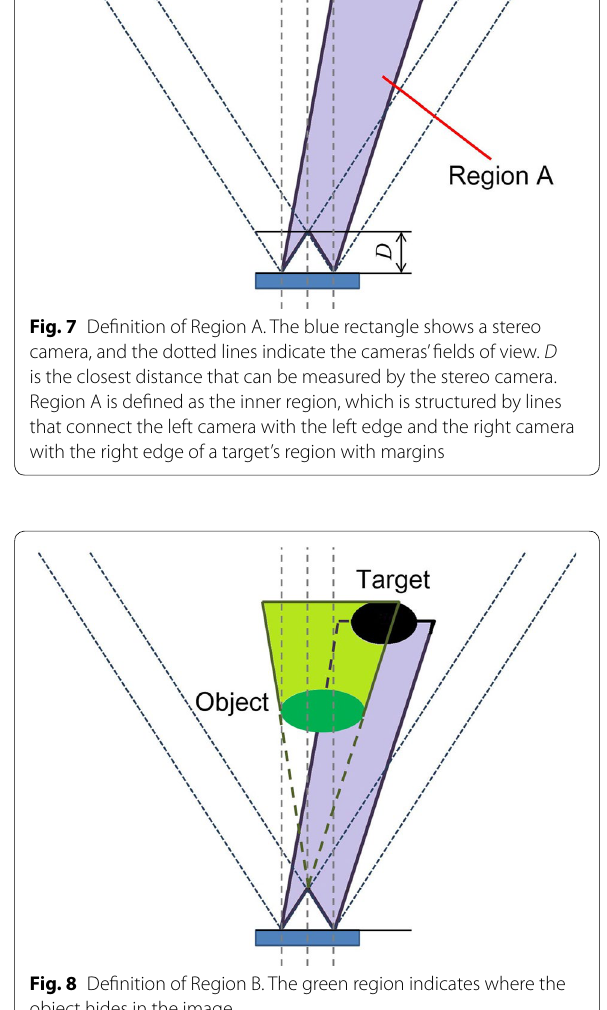
with the right edge of a target’s region with margins. When there are objects/people in Region A, the partial/ total region of a target is (or is going to be) hidden in an image, i.e. occlusion occurs. While occlusion continues, Region B is structured as the region hidden by the object in Region A (Fig. 8). By using Regions A and B, and also based on the result of target identification, the state of occlusion is classified into three types: STATE 1, 2, and 3.